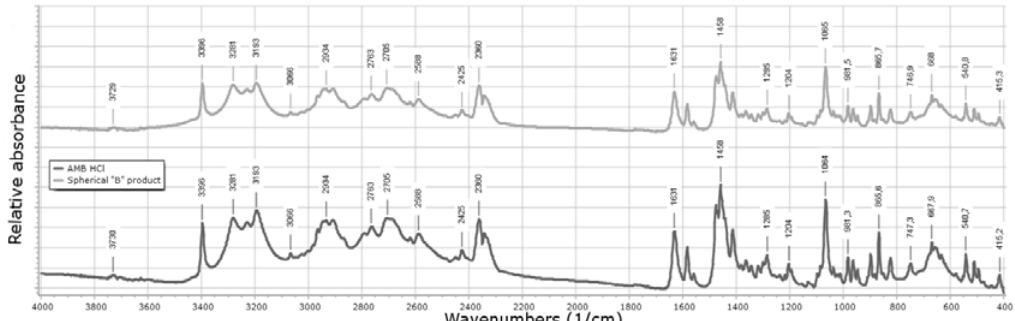
Figure 7. FTIR spectra of the original AMB HCl and the spherical agglomeration product (SAB)